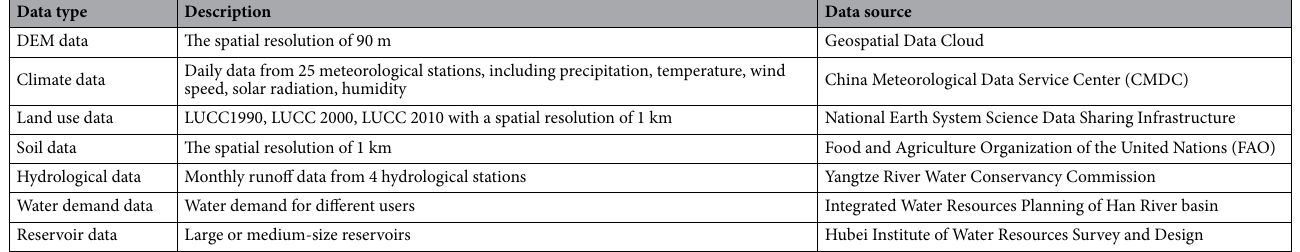
Table 2. Description of the dataset used in this study.